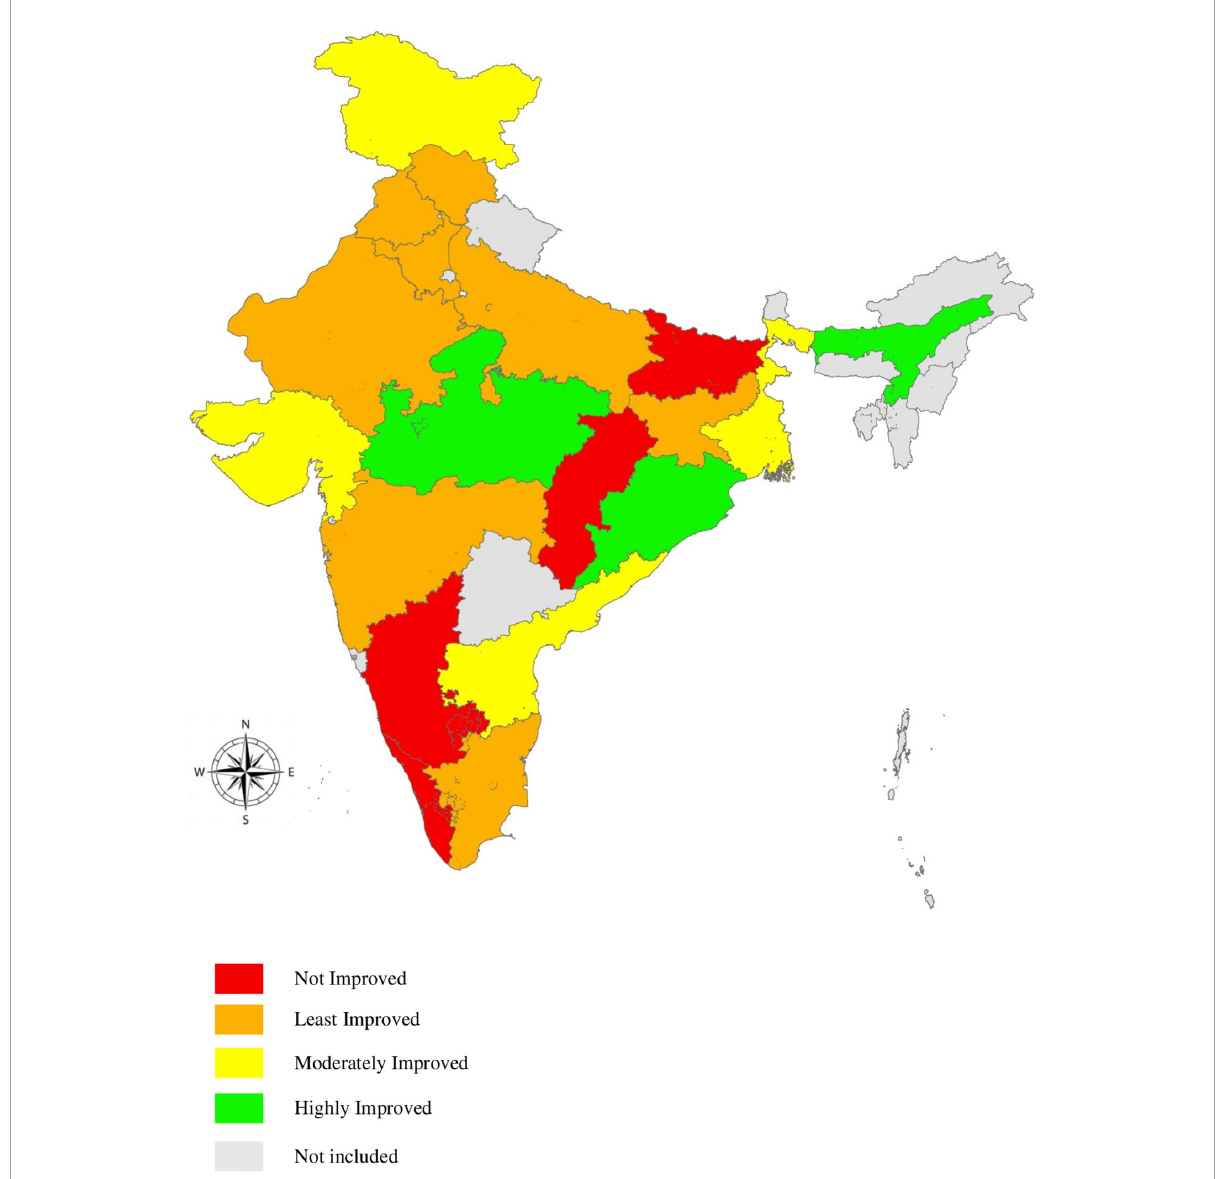
FIGURE2 Mapping of Indian states into typologies based on incremental changes of composite age-specific mortality index scores. The map has been created using ArcGIS R (cid:13) trial version 10.8 by Esri. ArcGIS R (cid:13)